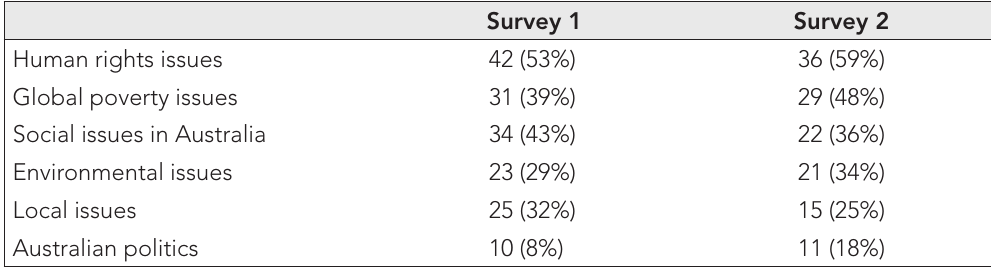
Table 6: PSTs’ level of interest by issue (respondents indicating ‘very interested’) Survey 1 Survey 2